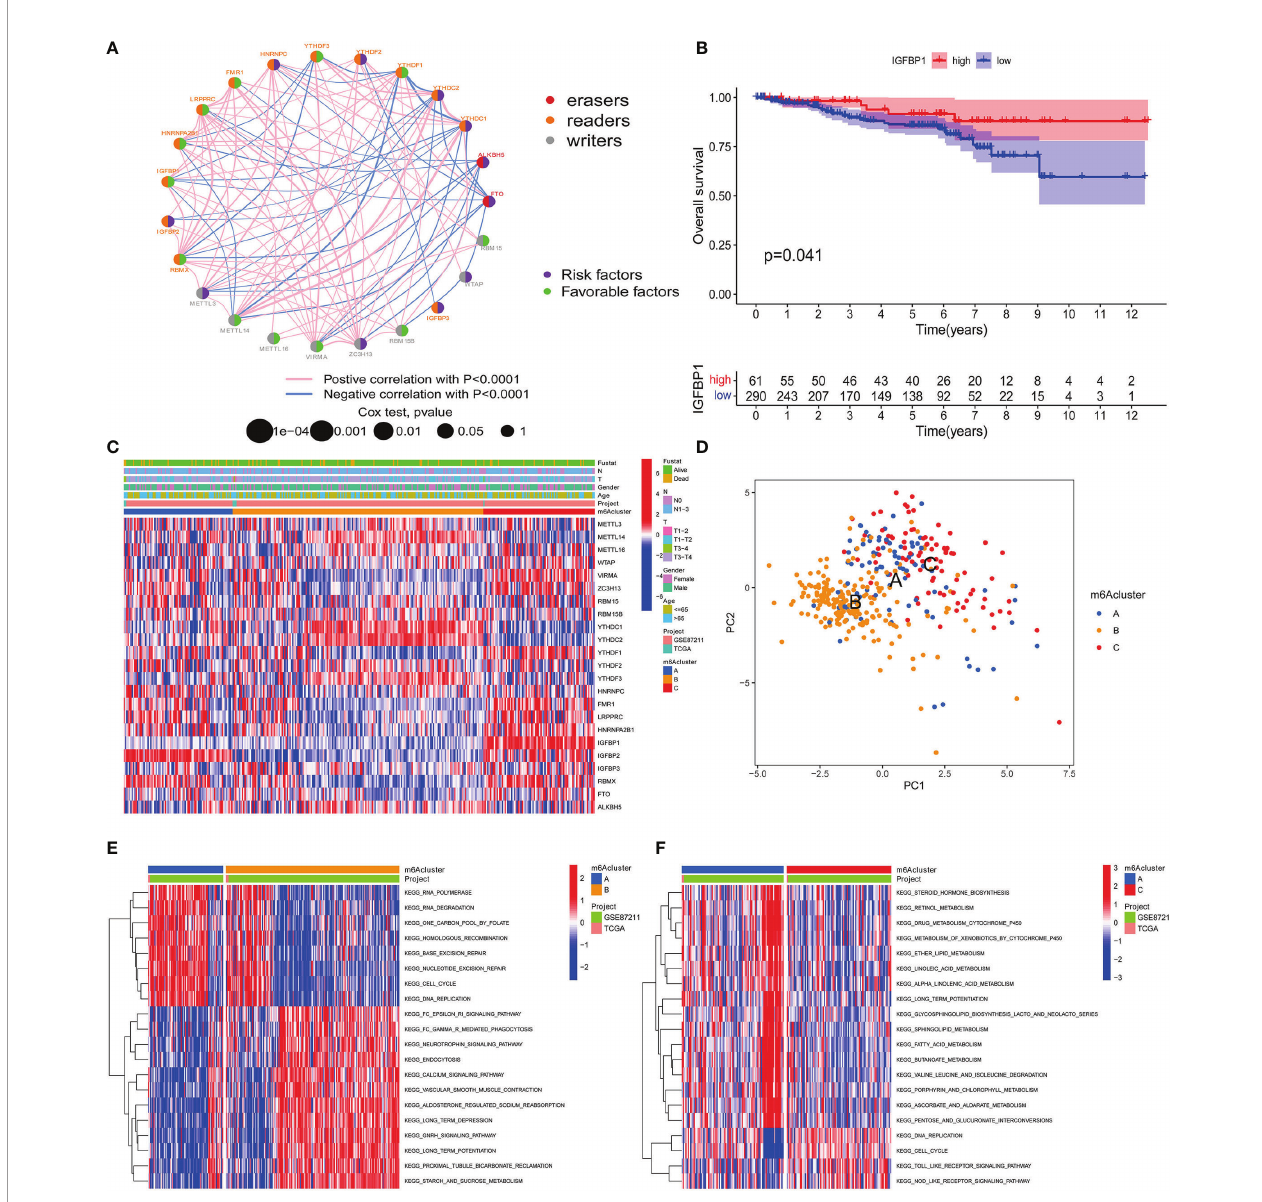
FIGURE 3 | m6A methylation modi fi cation patterns and related clinical features. (A) The interaction of m 6 A regulatory factors in rectal cancer. The size of the circle represents the in fl uence of each adjusting factor on the prognosis, and the range of the calculated value of the Log-rank test is p<0.0001, p<0.001, p<0.01, p<0.05, p<1. The purple dots in the circle indicate prognostic risk factors; the green dots in the circle indicate prognostic protective factors. The line connecting the regulators represents the interaction between them, and the thickness represents the relative strength between the regulators. Blue is a negative correlation, and pink is a positive correlation. The regulatory factors ( “ eraser ” , “ reader ” , and “ writer ” ) are marked in red, brown, and gray, respectively. (B) Kaplan-Meier curve of the patient group with high and low expression of IGFBP1. The number of high and low expression groups of patients were indicated in the bottom. Log-rank test, P = 0.041. (C) Unsupervised aggregation of 23 m 6 A regulatory factors in the GSE87211 rectal cancer cohort. Survival status, tumor stage, gender, age, project and m 6 Acluster are used as patient annotations. On the right, the bar with two colors indicates the level of gene expression and red color represents high expression while blue represents low expression. m6A cluster A – C were shown in blue, yellow and red, respectively. (D) Principal component analysis of the transcriptome pro fi les of the three m6A modi fi cation patterns. Blue dots represent m6A cluster A, yellow represent m6A cluster B and red represent m6A cluster C. (E, F) KEGG enrichment analysis shows the activation status of biological pathways with different m 6 A modi fi cation modes. Heat maps are used to visualize these biological processes. Red represents activated pathways and blue represents inhibited pathways. Take rectal cancer GSE87211 cohort as sample annotation. (E) m 6 Acluster A vs m 6 Acluster B; (F) m 6 Acluster A vs m 6 Acluster